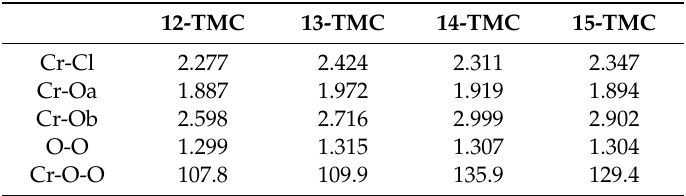
Table 1. Main geometrical parameters for the most stable structures of [Cr(III)(12-TMC)(O 2 )(Cl)] +